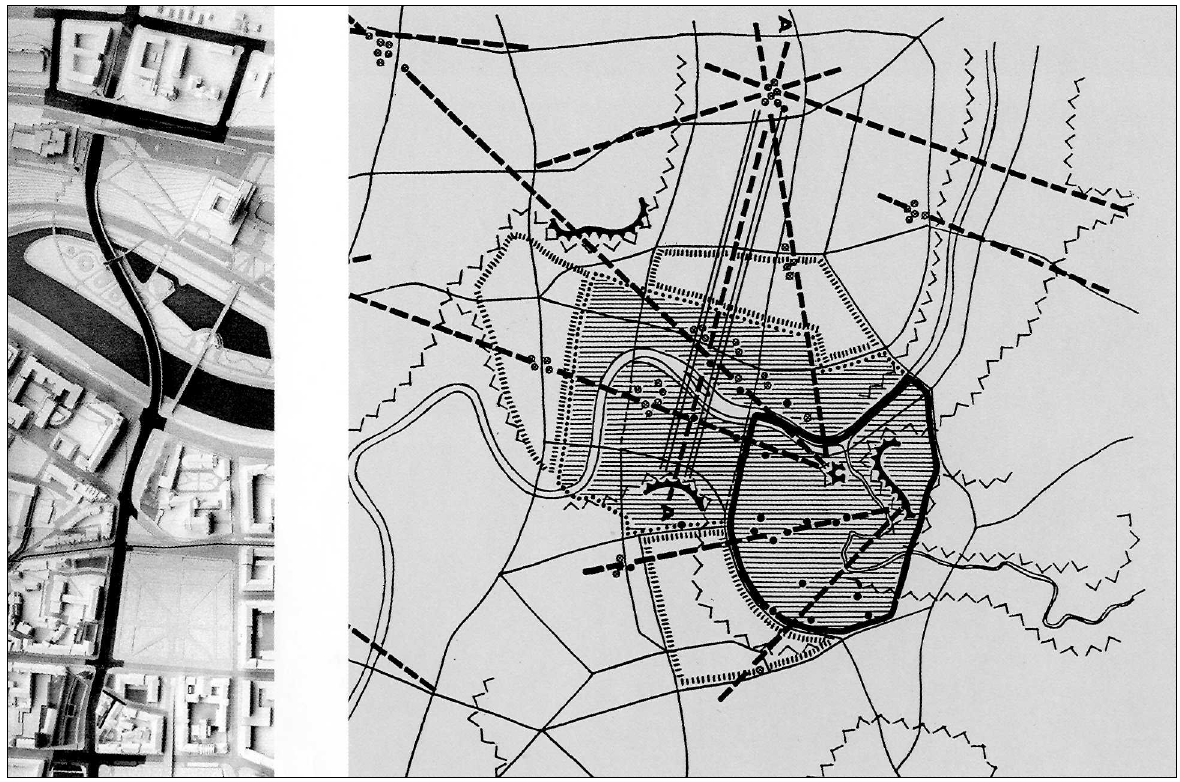
Fig 7. Conception of the new center design axis development (arch A. Nasvytis, 1974–2002) Leftwards – proposal of the new (hooked) transport bridge, on the right – location of the suggested axis in the center